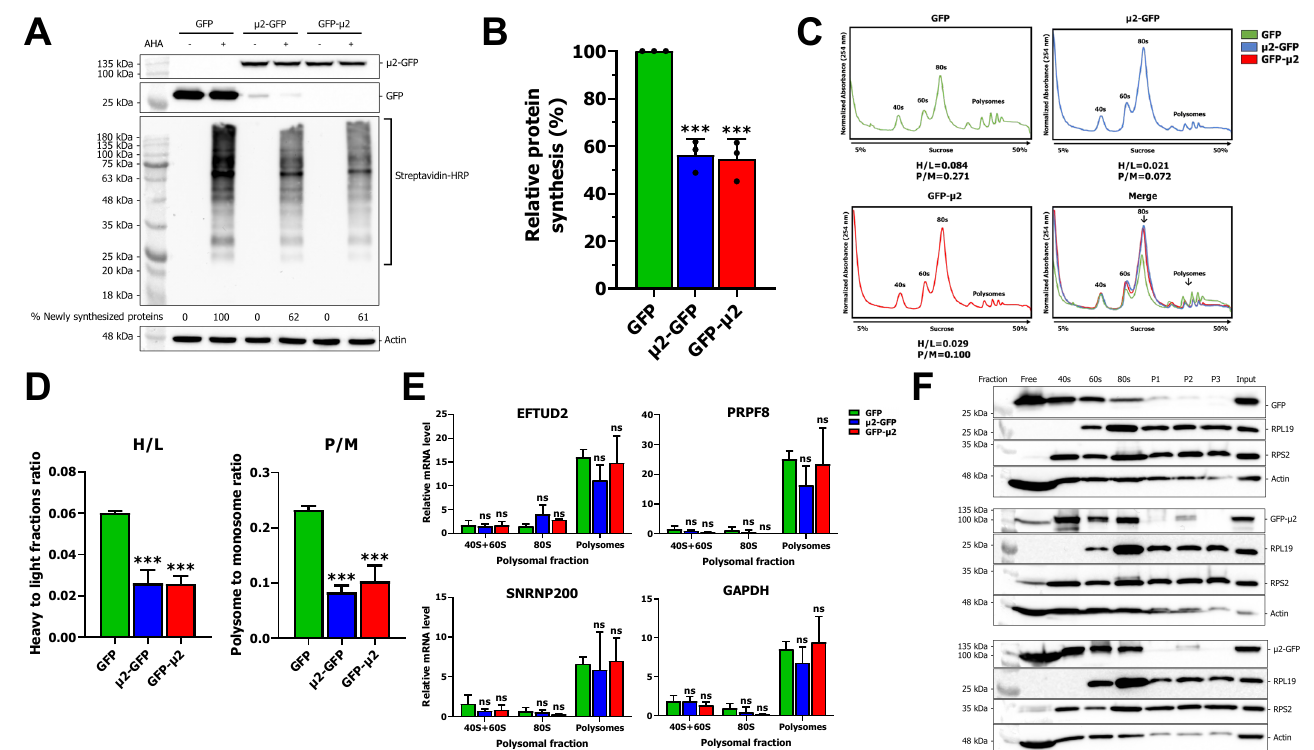
Figure 2. The µ 2 protein impairs translation: ( A ) WB of newly synthesized proteins in HEK 293T cells expressing GFP, µ 2-GFP, or GFP- µ 2. Cells were transfected for 48 h, newly synthesized proteins were metabolically labeled with AHA for 4 h (or DMSO for control), a biotin moiety was added using CLICK chemistry and revealed using streptavidin-HRP. A loading control (actin) was loaded and a WB against GFP was realized to validate the expression of GFP and fusion protein between GFP and µ 2; ( B ) quantification of three independent experiments. Biological replicates, n = 3, one-way ANOVA with Dunnett’s multiple comparisons test against the GFP alone condition (***, p ≤ 0.001); ( C ) polysome profiles for control GFP or µ 2-expressing cells. Polysome to monosome ratio (P/M) and heavy to light ratio (H/L) were calculated as described in the material and methods section. Respective profiles were overlapped by aligning the 40S to the same height; ( D ) polysome to monosome ratio (P/M) and heavy to light ratio (H/L) from three independent experiments for control GFP or µ 2-expressing cells. Biological replicates, n = 3, one-way ANOVA with Dunnett’s multiple comparisons test against the GFP alone condition (***, p ≤ 0.001); ( E ) relative mRNA level determined by qPCR for EFTUD2, PRPF8, SNRNP200, and GAPDH in 40S + 60S, 80S, and polysomal (P1 + P2 + P3) fractions from GFP or µ 2-GFP expressing cells at 48 h post-transfection. Lysates were prepared, separated on a 5–50% sucrose gradient, and 30% of each fraction was subjected to RNA extraction using Qiazol. RNA was reverse transcribed using a fixed volume for each sample and subjected to qPCR with U6 snRNA as the housekeeping gene, as it was stable between all fractions. The relative expression is calculated against the first sample in the GFP condition for the 40S + 60S fraction. n = 3, biological replicates, two-way ANOVA with Dunnett’s multiple comparisons test against the GFP control for each fraction (ns, p > 0.05); and ( F ) WB against GFP, RPL19 (large subunit), RPS2 (small subunit), and actin in polysomal fractions from control GFP or µ 2-expressing cells at 48 h post-transfection in HEK 293T cells. Results presented are mean ± standard